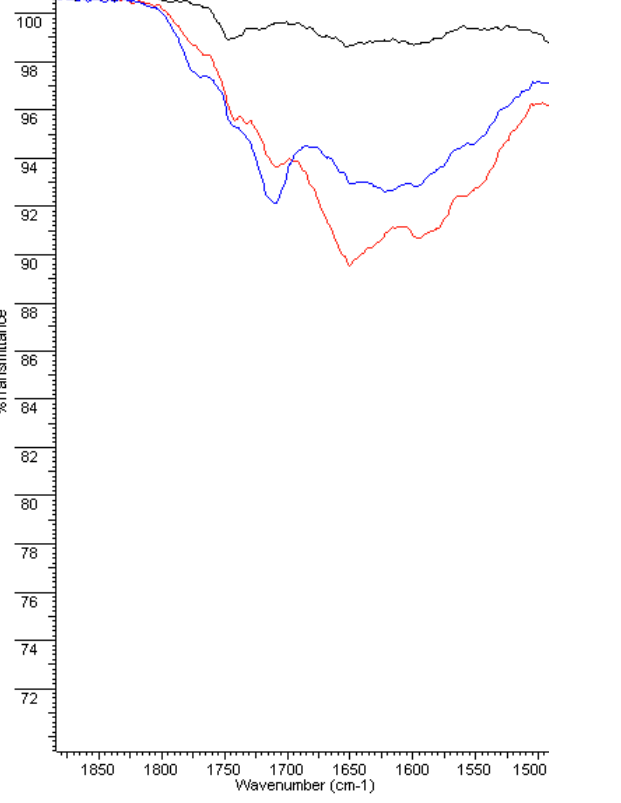
Figure 7. FT-IR spectra of PPR inner surface: new ( black ), 4 weeks ( red ), and 8 weeks ( blue )—magnification of 1900–1500 cm − 1 region .